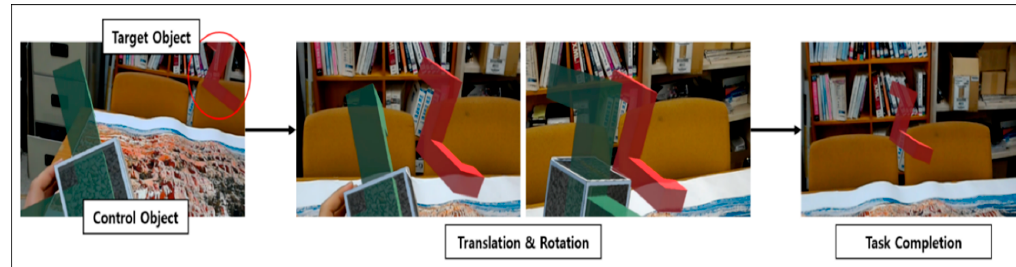
Figure 19. Additional 3D matching task between the physical control object and the virtual target object.